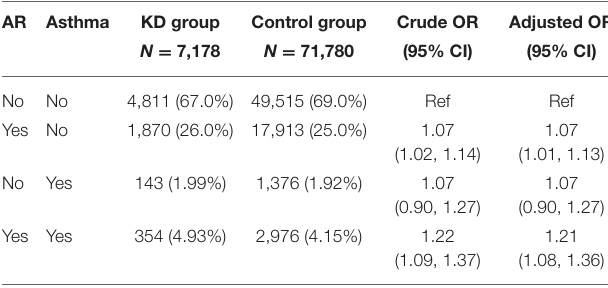
TABLE 4 | Odds ratio of maternal allergic rhinitis and asthma in KD group and control